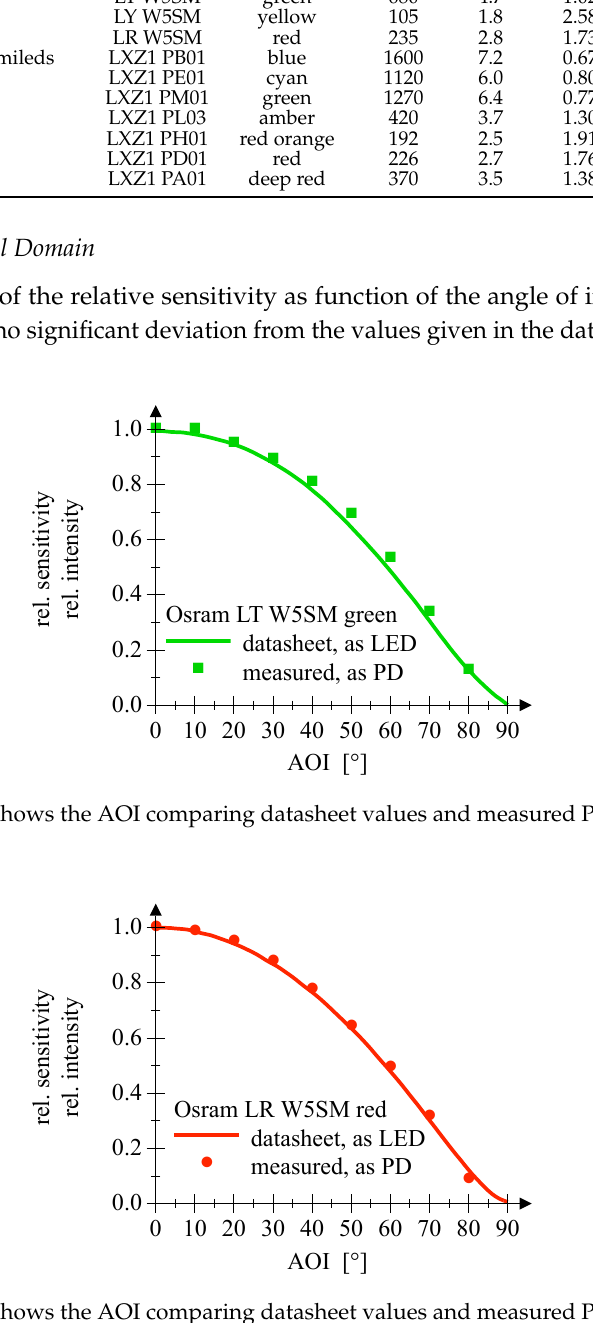
Figure 13. This plot shows the AOI comparing datasheet values and measured PD employment of a red Osram